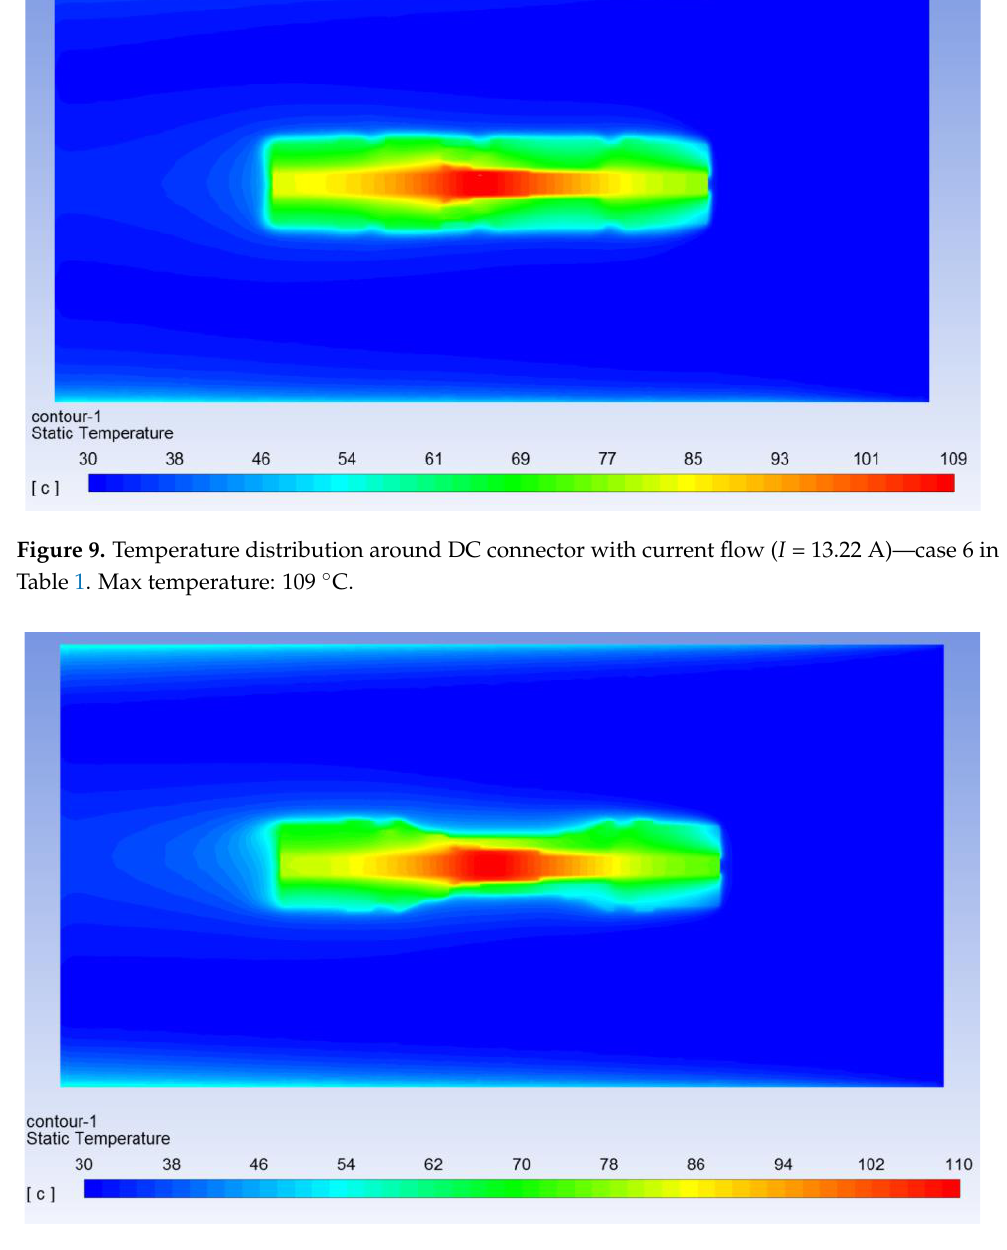
Figure 11. Temperature distribution around DC connector with current flow ( I = 9 A) — case 8 in Table 1. Max temperature: 113 °C. As the contact resistance increases, the maximum DC connector temperature also in- creases. It is worth emphasizing that, according to the manufacturer ’ s card, the upper temperature limit of the connector is equal to 105 °C. Therefore, in the cases shown in Figures 9 – 11, this temperature has been exceeded, which results in a reduction in the du- rability of the connector, its possible change in structure, and possible loss of insulating properties. A summary of the calculation results of the connector heating, depending on the contact resistance, is shown in Figure 12.